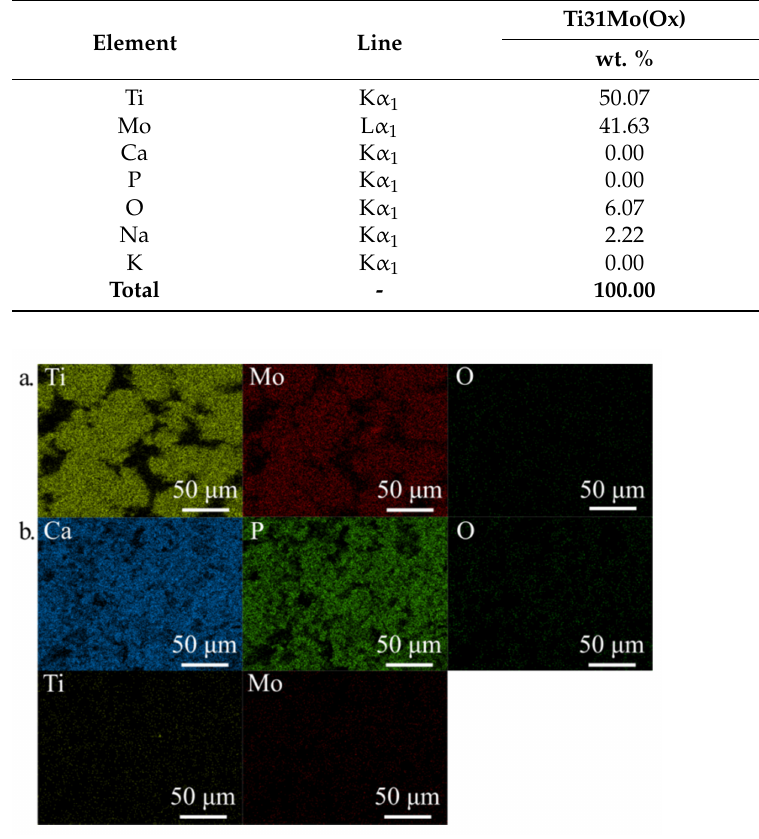
Figure 5. EDS mapping for Ti31Mo after NaOH 60 ◦ C/24 h ( a ) and hydrothermal treatment ( b ).